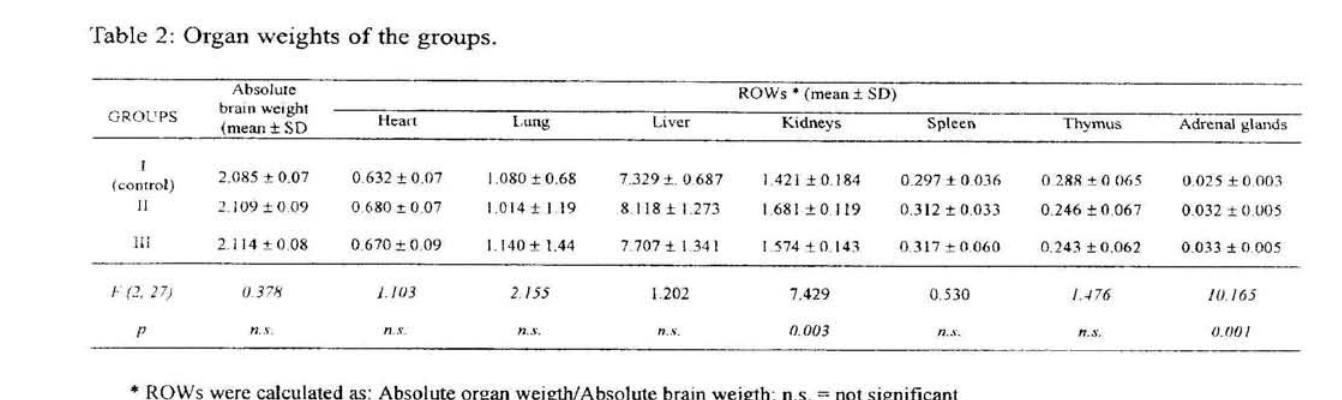
* ROWs were calculated as: Absolute organ weigth/Absolute brain weigth; n.s = not significant